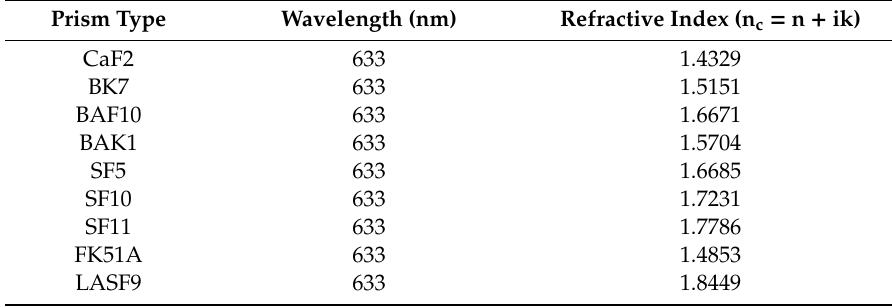
Table 3. Some refractive index database of prisms at a wavelength of 633 nm taken from the database of SCHOTT (Mainz, Germany) optical glass